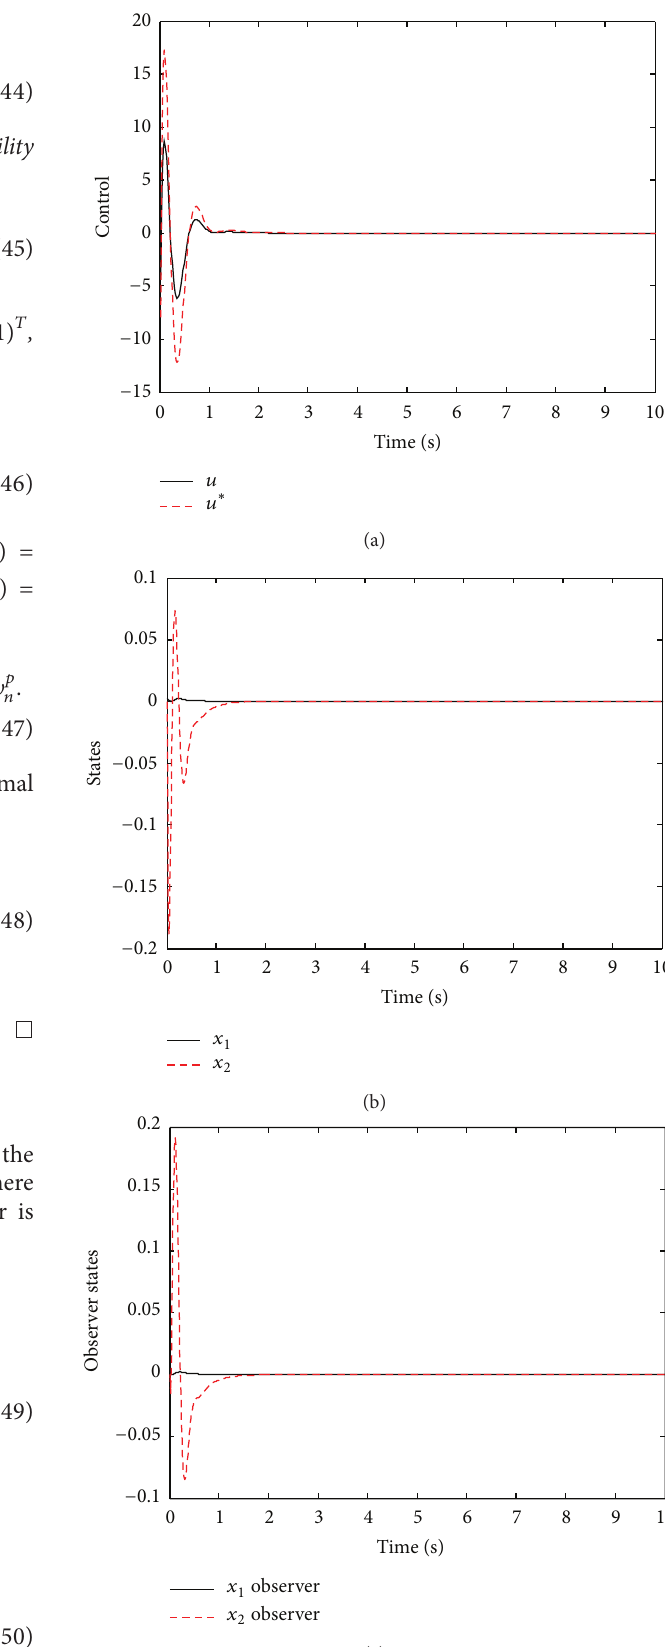
Figure 1: The responses of the closed-loop systems (49) ∼